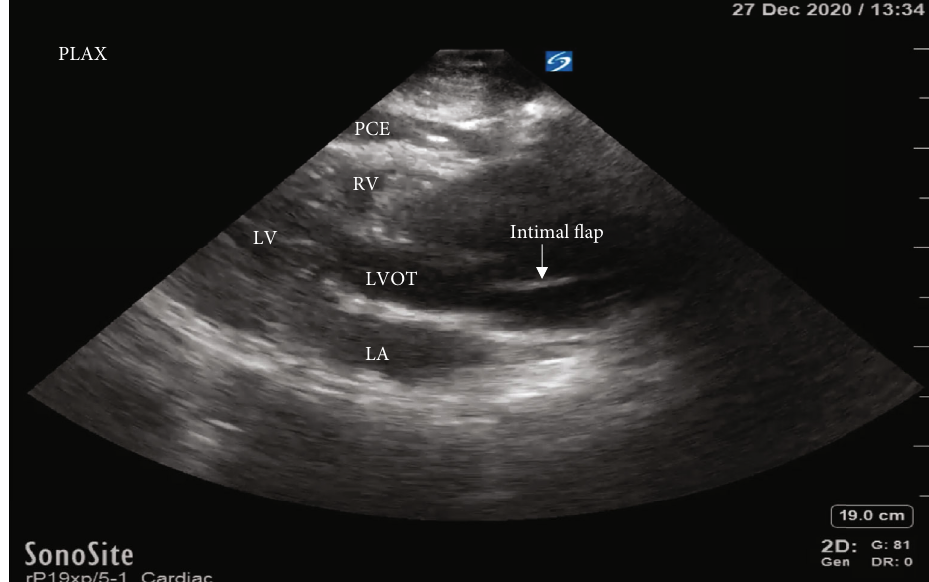
Figure 4: Parasternal long axis displaying the intimal fl ap within the aortic out fl ow tract. LA: left atrium; LV: left ventricle; RV: right ventricle; PCE: pericardial e ff usion; LVOT: left ventricular out fl ow